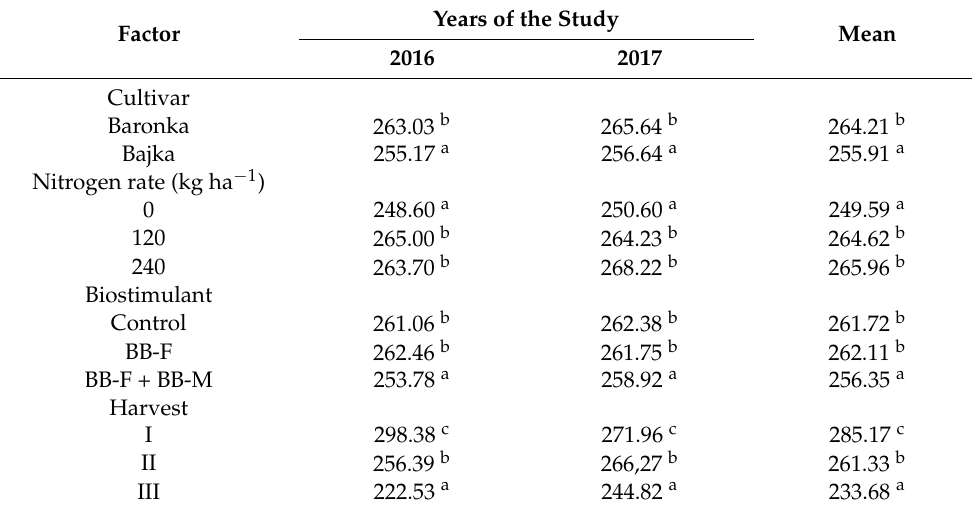
Table 3. Content of crude fiber in perennial ryegrass biomass (g kg − 1